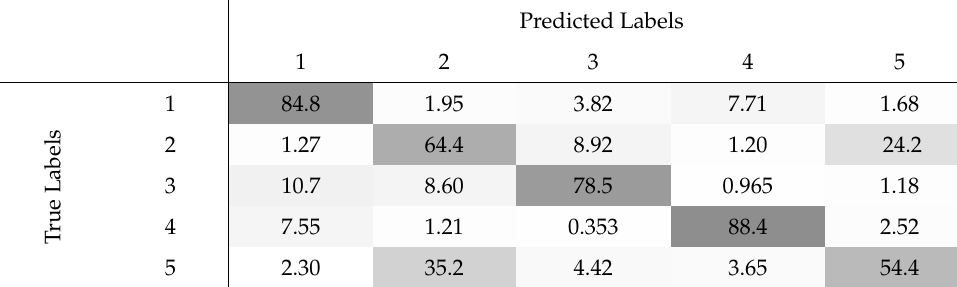
Table 2. Experiment I: Confusion matrix of our neural network.